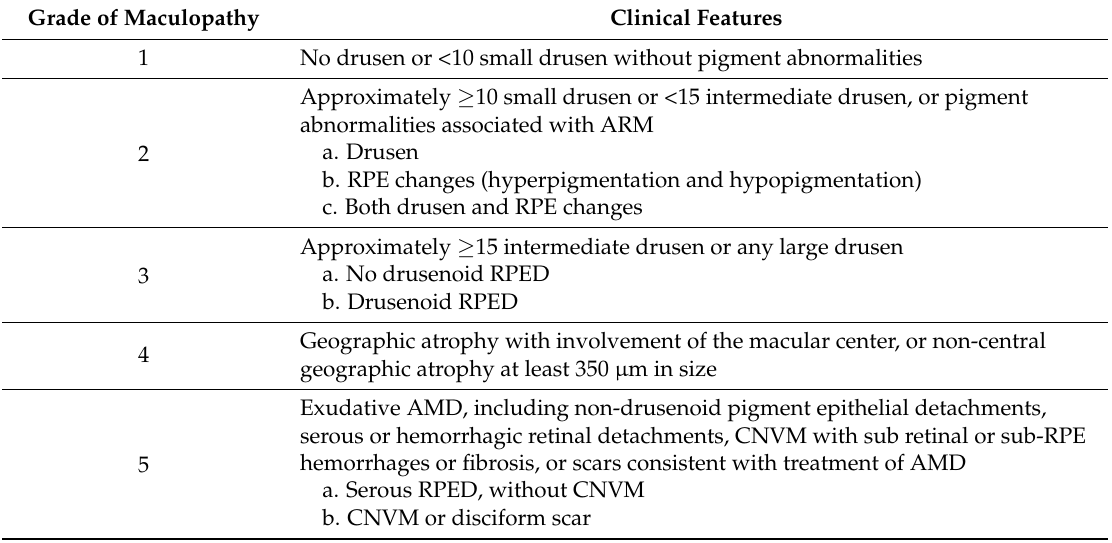
Table 1. The Clinical Age-Related Maculopathy Staging (CARMS)